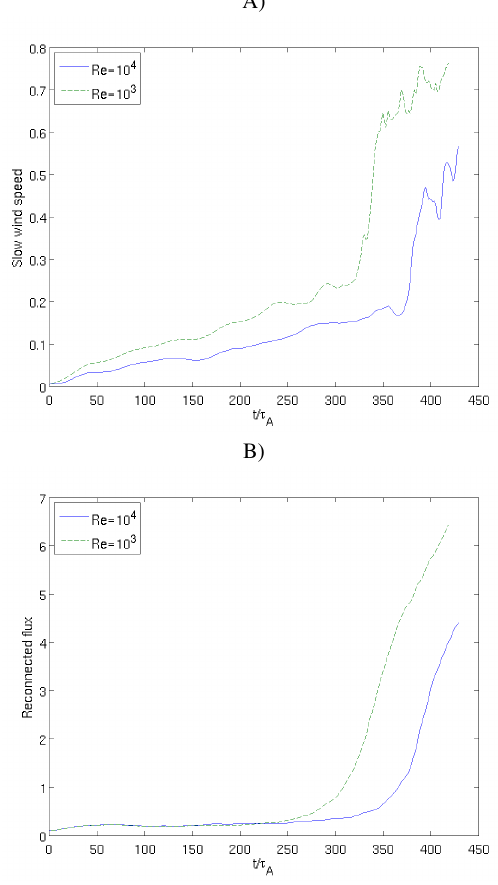
Fig. 3. Evolution of the average velocity profile < v x ( z ) > x (nor- malised to the asymptotic speed u 0 ) for two runs starting from the initial force-free reversed field equilibrium with the same resistivity ( S = 10 4 ) but different viscosity (panel A with R v = 10 4 , panel B R v = 10 3 ).